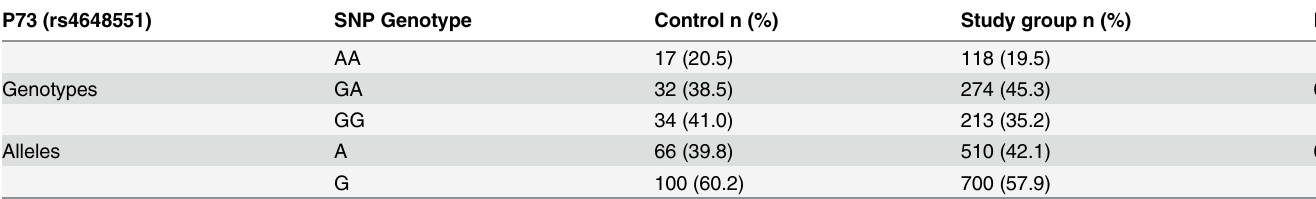
Table 1. Genotypes and alleles frequencies distribution in the control and study groups. P73 (rs4648551)